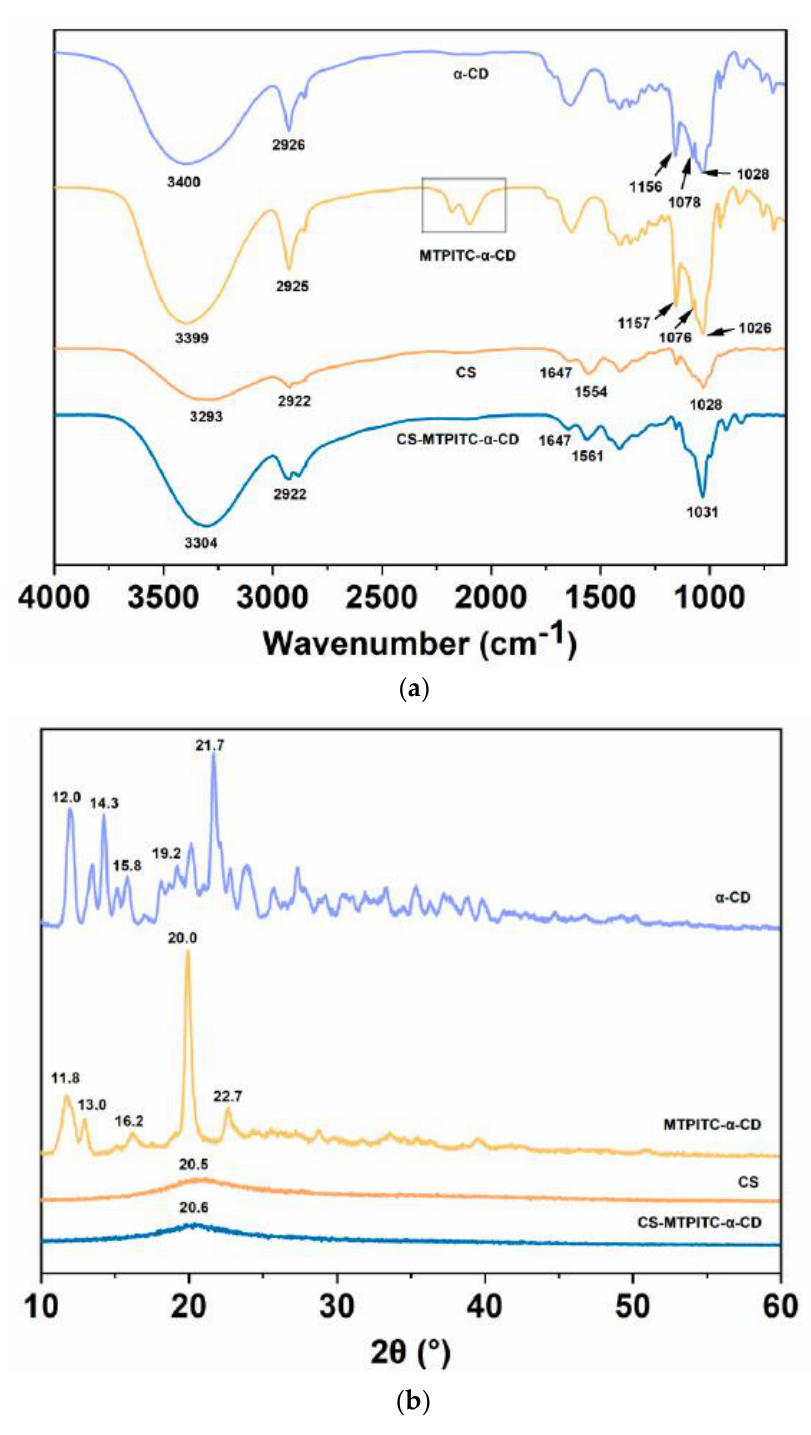
Figure 1. Structural characterization of the MTPITC −α− CD inclusion complex and the CS − MTPITC −α− CD film. ( a ) FTIR spectra of α− CD, MTPITC −α− CD, CS, and CS − MTPITC −α− CD; ( b ) XRD patterns of α− CD, MTPITC −α− CD, CS, and CS − MTPITC −α− CD.